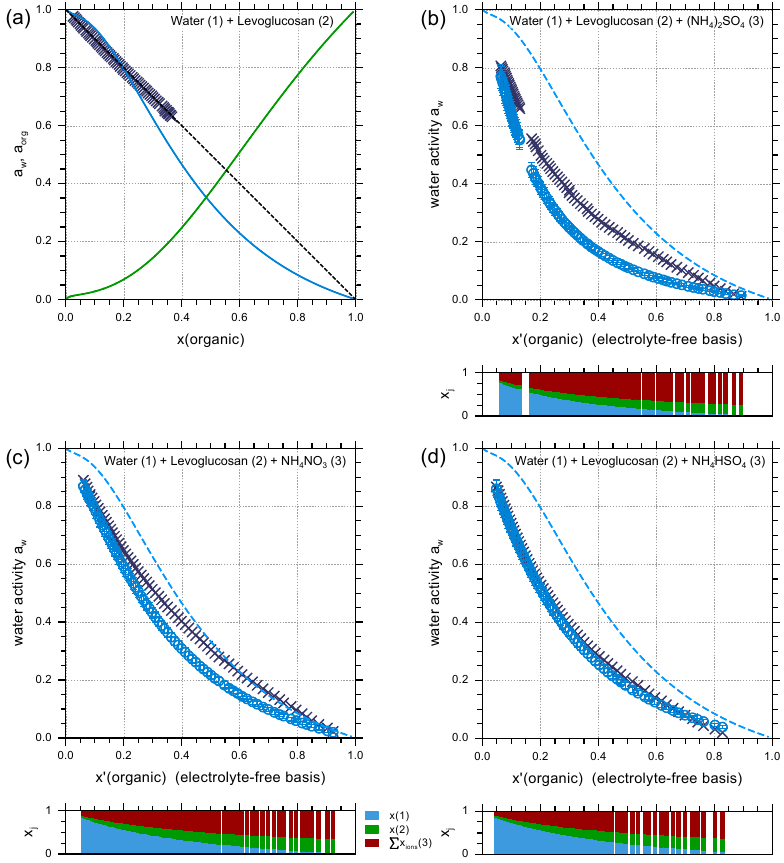
Fig. 14. Water activities of the binary and ternary water (1)+levoglucosan (2)+electrolyte (3) systems at 291K. (a) In case of the binary system, the EDB water activity data ( ) closely matches an ideal solution (dashed line). The AIOMFAC (UNIFAC) a w -curve (blue line) shows larger deviations. The green curve shows the corresponding calculated activity of levoglucosan. (b) , (c) , and (d) Ternary systems containing the electrolytes ammonium sulfate, ammonium nitrate, and ammonium bisulfate, respectively, mixed at a molar ratio of 1 : 1 with levoglucosan. Symbols show the experimental water activity data ( ) and corresponding AIOMFAC calculations ( ). Error bars of the experimental data are smaller than the symbol size. The dashed, blue curve shows the electrolyte-free a w model curve for comparison. Measurements by Lienhard et al.